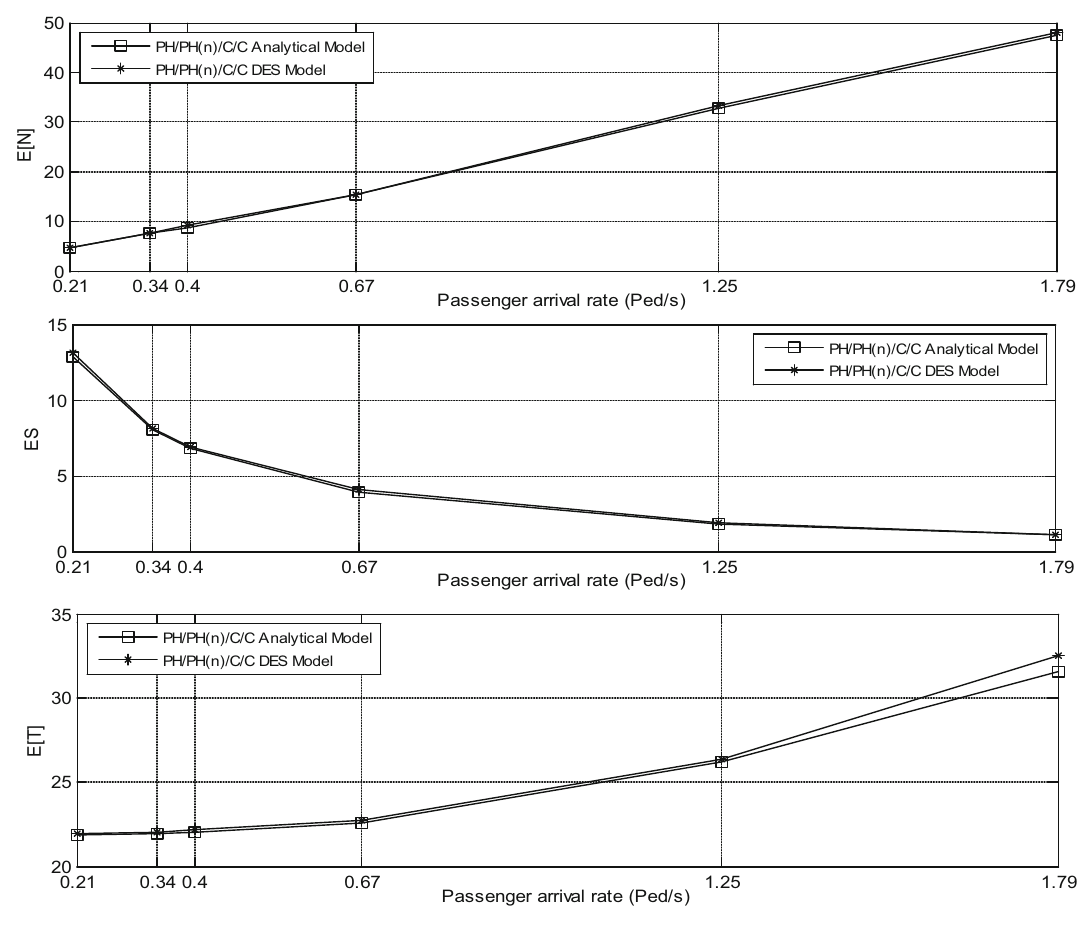
Fig. 5 Verification of the PH/PH( n )/C/C DES model